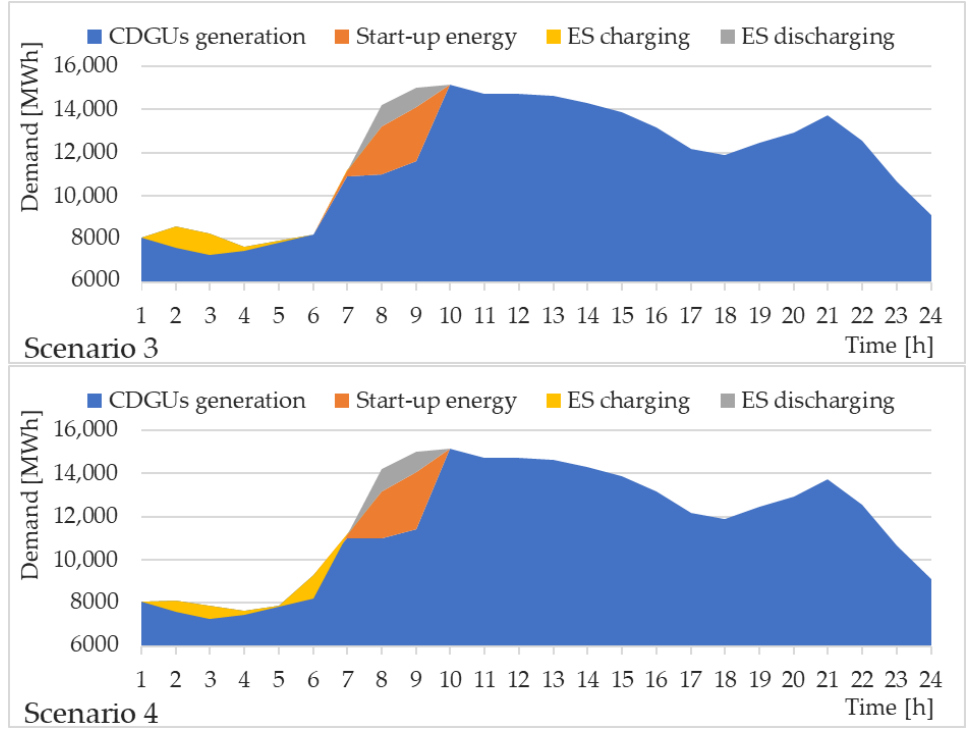
Figure 7. Results—distribution of generation, start-up energy, and energy storage (ES) operation.